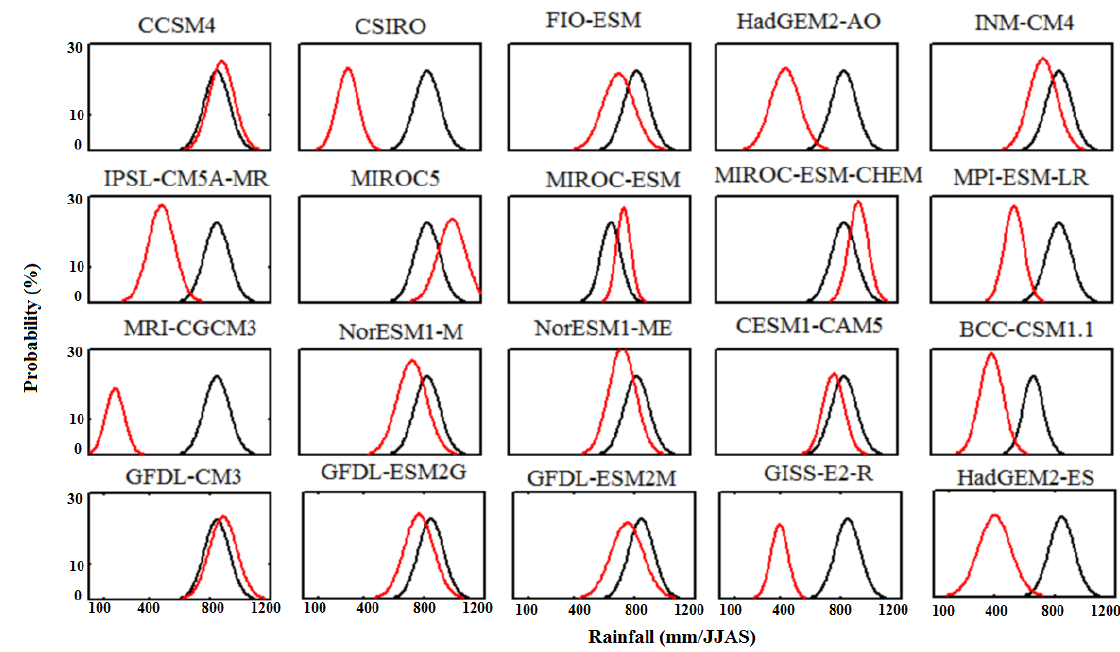
Figure 4. Probability density function for 20 models and observed data for AISMR. Black line represents observed data and red is for model data. The x-axis represents the precipitation of the models and the y-axis represents probability (in %).